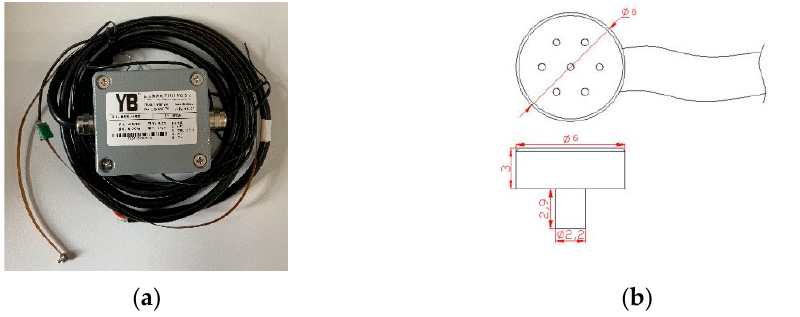
Figure 3. Miniature pressure sensors. ( a ) Miniature Dynamic Pressure Sensor Physical Drawing, ( b ) Pressure measuring probe form factor. Table 2. Main performance parameters of pressure sensors.